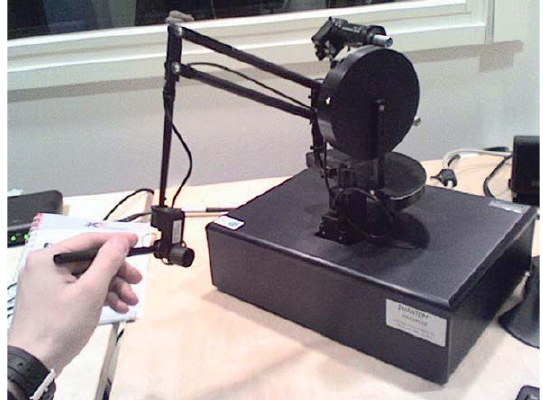
Fig. 11. Phantom haptic master (Sensable, Wilmington, MA). This mater is able of providing up to six d.o.f. force feedback.